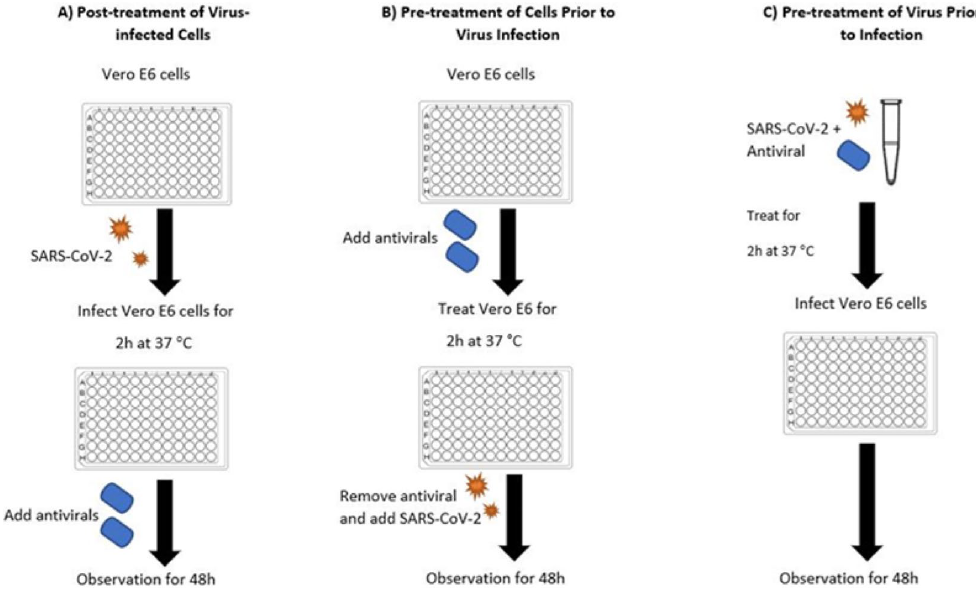
Figure 1. General outline of anti-viral assays. Vero E6 cells were cultured in 96 well-culture plate and used in the three workflows: Post-treatment of Virus-infected Cells ( A ), Pre-treatment of Cells Prior to Virus Infection ( B ), Virucidal ( C